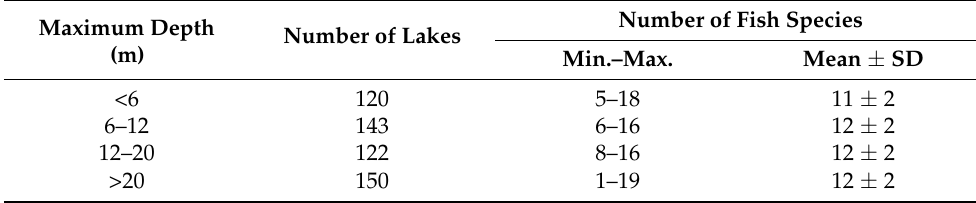
Table 3. The number of lakes and the number of fish species in lakes of different maximum depth. SD = standard